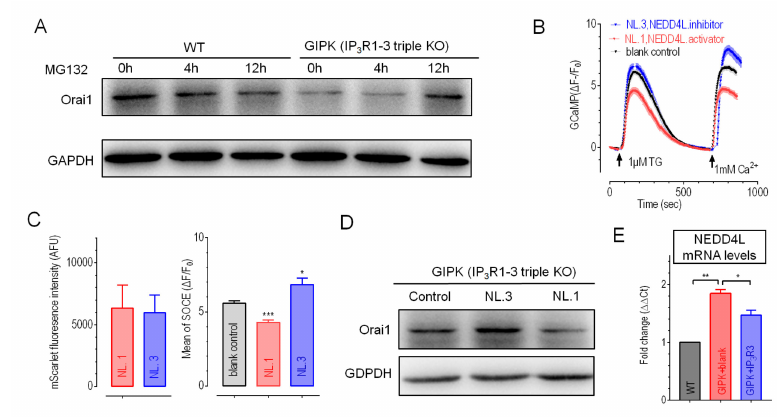
Figure 4. The expression of Orai1 and SOCE amplitudes in IP 3 Rs-TKO cells could be regulated by modulating activities of NEDD4L. ( A ). Representative Western blotting results of GIPK or WT GCaMP cells after incubation of MG132 (10 µ M), a proteasome inhibitor. Densitometric analysis of all repeats showed that, after 12-h treatments, Orai1 levels in GIPK cells were significantly increased. (Normalized against GAPDH, * P < 0.05, Paired t -test, n = 3). ( B – C ). E ff ects of NL.1 or NL.3 overexpression in GIPK cells. ( B ), Typical traces; ( C ), Statistics. Left, statistics of mScarlet fluorescence, indicating the relative expression of mScarlet-P2A-NL.1 / NL.3; Right, statistics of mean SOCE responses shown in ( B ). Compared to blank controls, inhibition of NEDD4L with NL.3 significantly increased SOCE, while NL.1 significantly reduced SOCE in GIPK cells (* P < 0.03; *** P < 0.002, Student’s t -test, n = 3). ( D ) Typical Western blotting results. Densitometric analysis of all repeats showed that both NL.1 and NL.3 significantly altered Orai1 protein levels (NL.1 vs blank, P < 0.02; NL.3 vs blank, P < 0.04; Student’s t -test, n = 3). ( E ) mRNA levels of NEDD4L in WT or GIPK cells with or without overexpression IP 3 R3. (** P < 0.002; * P < 0.02, Paired t -test, n =